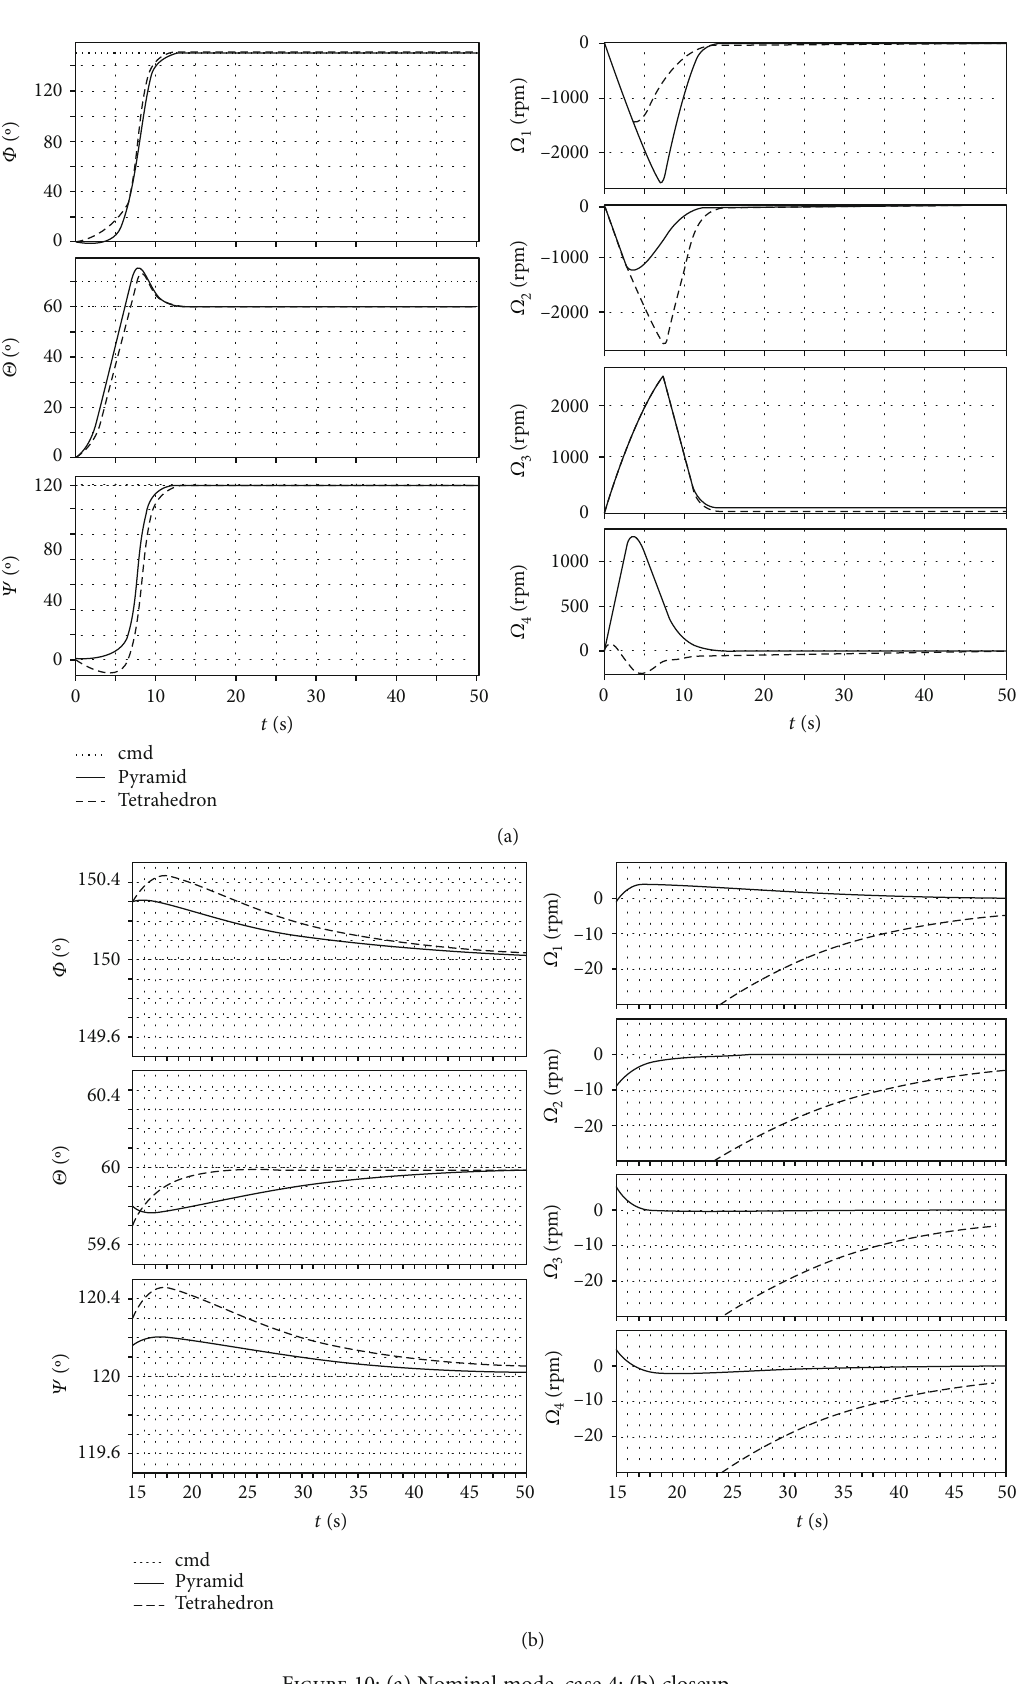
Figure 10: (a) Nominal mode, case 4; (b)